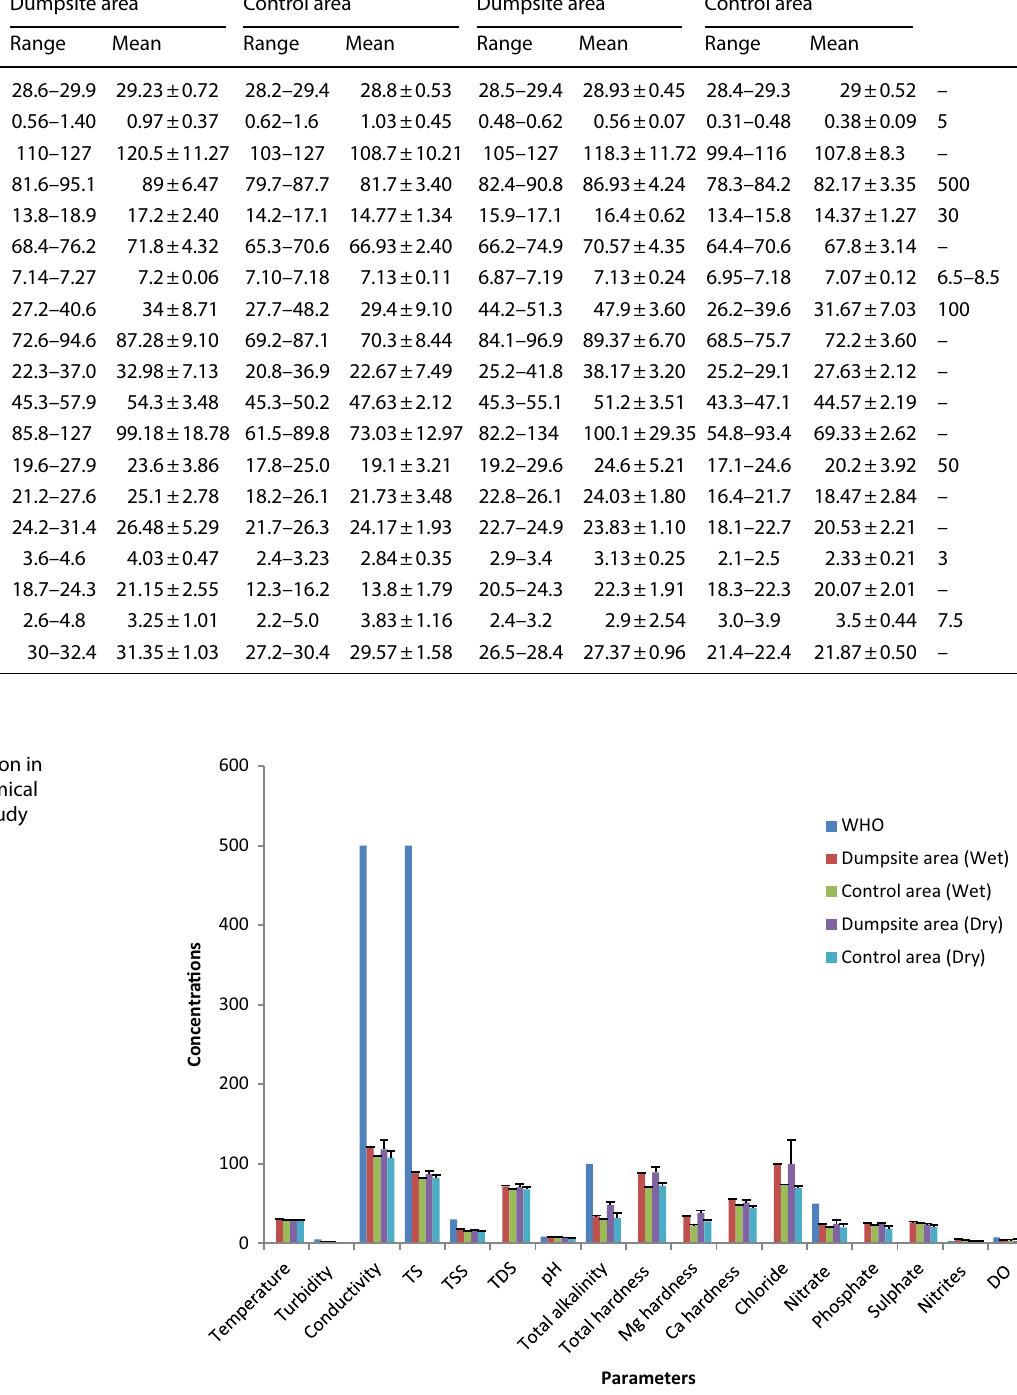
Table 1 Physicochemical properties of the borehole water samples